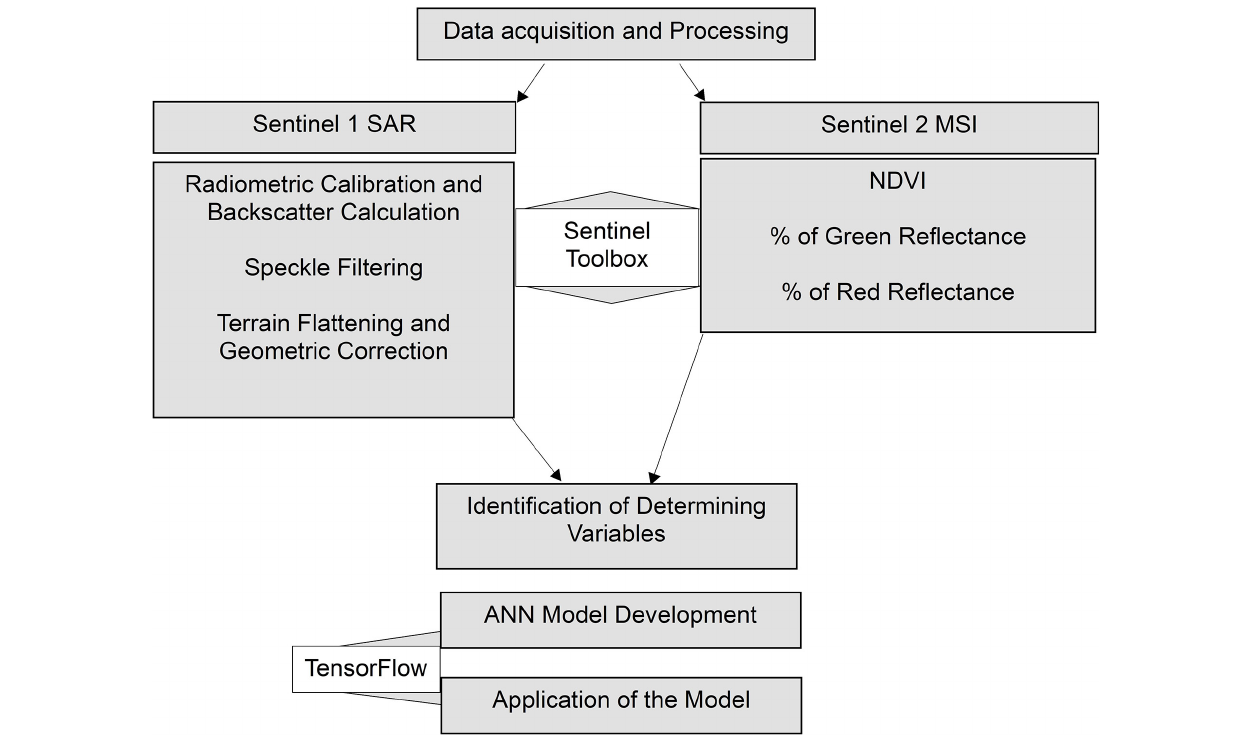
FIGURE 3 | The workflow developed for computing biomass using